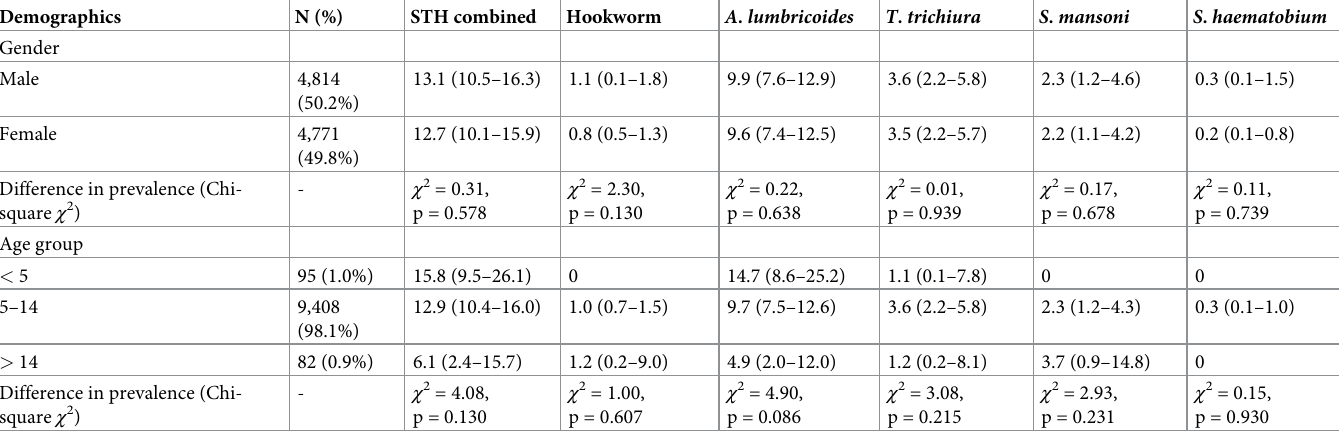
Table 3. STH and schistosomiasis prevalence % (95%CI) by demographics among school children in Kenya after five rounds of MDA. Demographics N (%) STH combined